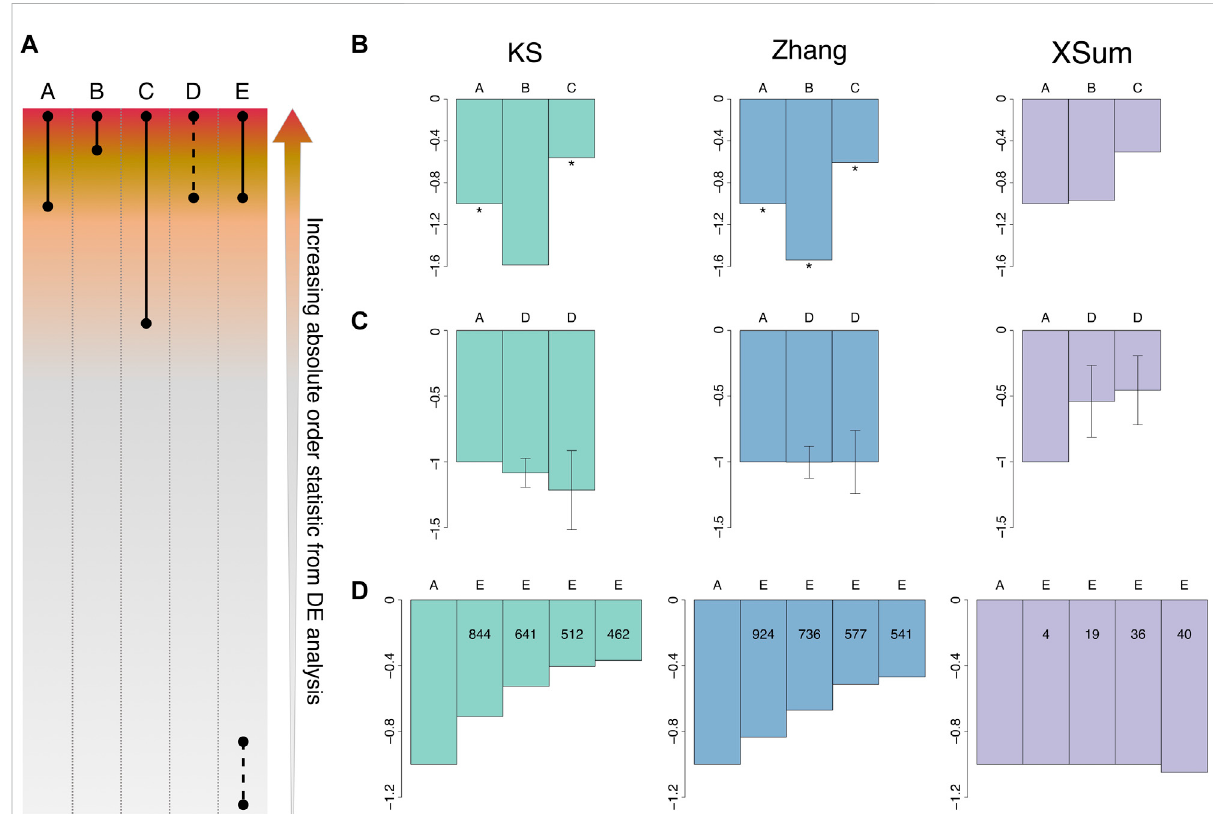
FIGURE 3 Signature quality in gastric cancer. (A) Schematic illustration of signature composition for Set A to E. Solid lines indicate all genes within the range are included in the query signature, dashed lines indicate a random subset of the genes in the range are included in the query signature. (B) Normalized scores by variation of gastric cancer signature quality. Scores are normalized to the baseline set A. Normalized scores for Set A, B and C. SizeofsetA:119genes,setB:43,setC:267.*indicatesasigni fi cantscore. (C) NormalizedscoresforsetAandsetsD.SizeofsetA:119genes,set D:78and39respectively.Errorbarsrepresentthestandarddeviationofthescores( n =1000). (D) NormalizedscoresforsetAandsetsE.SizeofsetA: 119 genes, additional number of non-DEGs in set E: 24, 60, 119 and 148 respectively. Internal numerals indicate the number of signi fi cant quality- diluted signatures. Green: KS, blue: Zhang, purple: